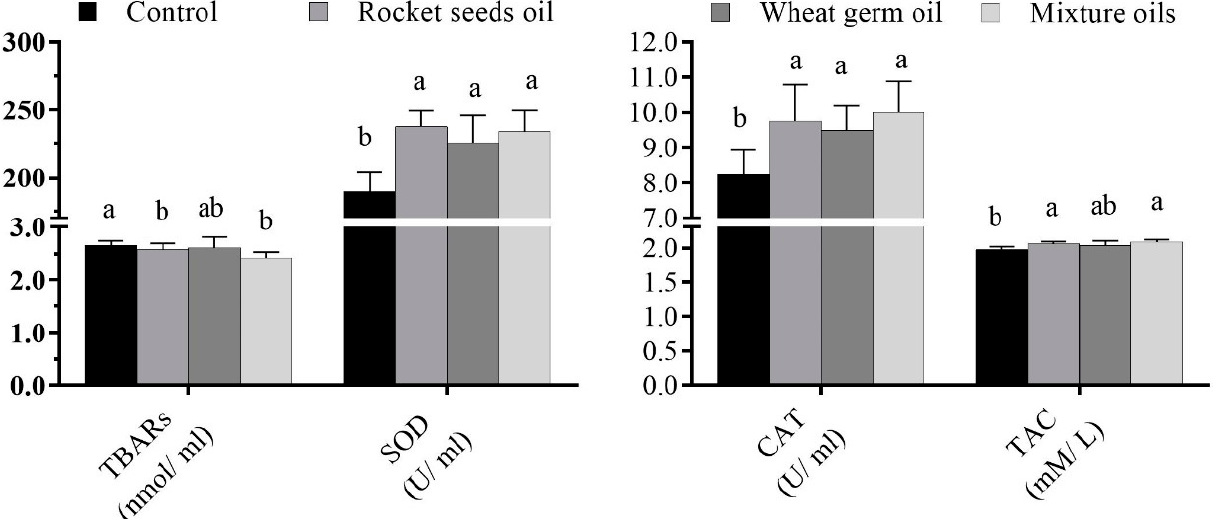
Figure 4. Serum thiobarbituric acid reactive substances and antioxidants status of V-line growing rabbits (5–12 weeks of age) that were administered orally with rocket seed oil, wheat germ oil, and their mixture. Columns marked with different superscripts are significantly different at p ≤ 0.05. CAT: Catalase; SOD: Superoxide dismutase; TAC: Total antioxidant capacity; TBARs: Thiobarbituric acid reactive substances.